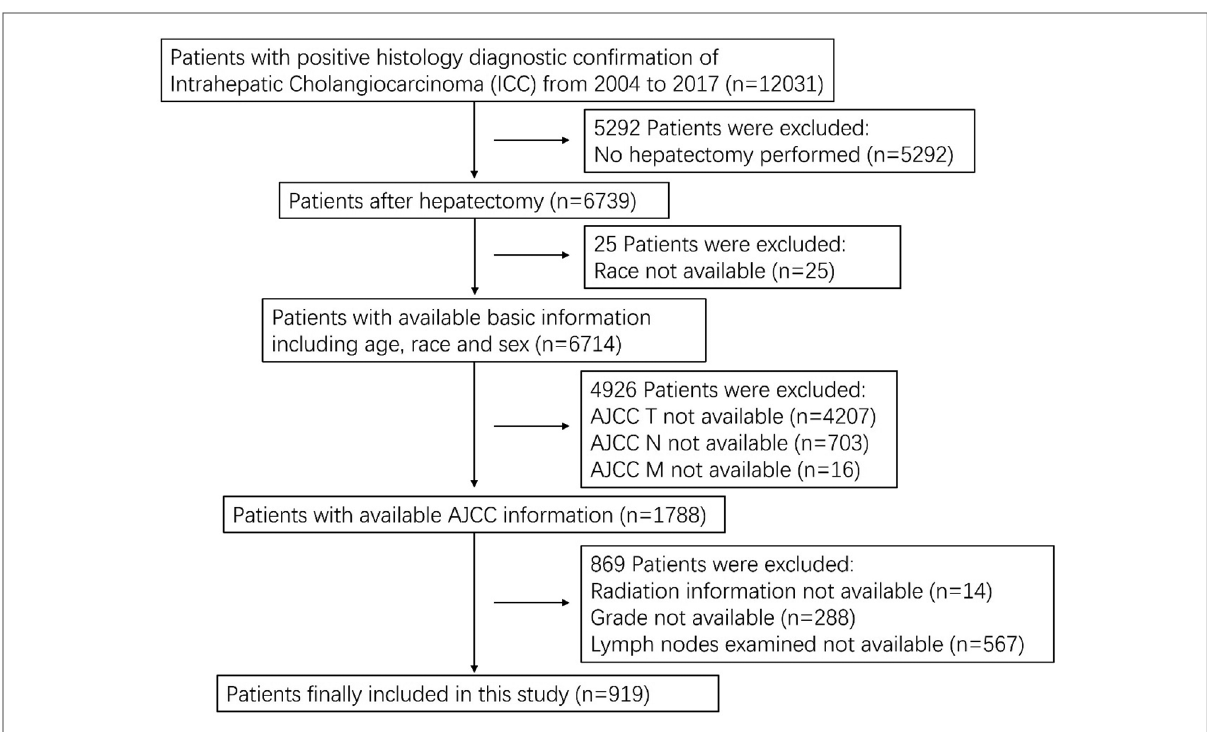
FIGURE 1 Flow chart of patients with ICC included in this